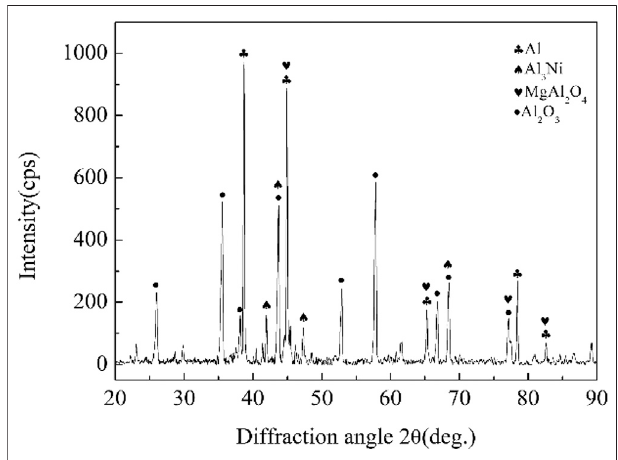
FIGURE 11 | XRD diffraction result of the fracture in Figure 10